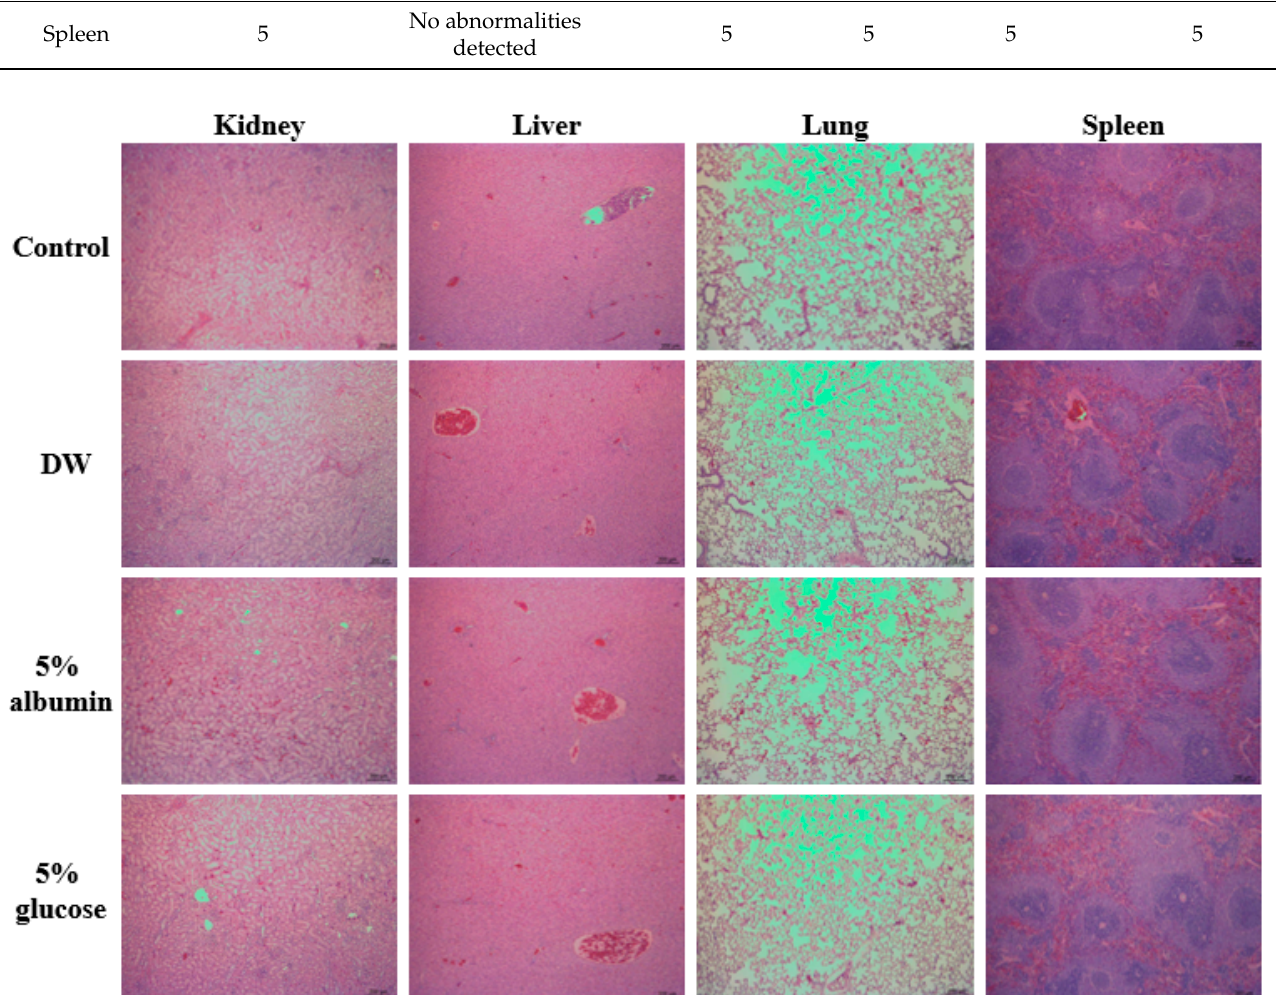
Figure 10. Normal histopathological sections of the kidney, liver, lung, and spleen of the rats after oral administration of ZnO NPs (100 mg/kg) interacted with DW, albumin, or glucose for 14 consecutive days. Images were magnified at 50 × .